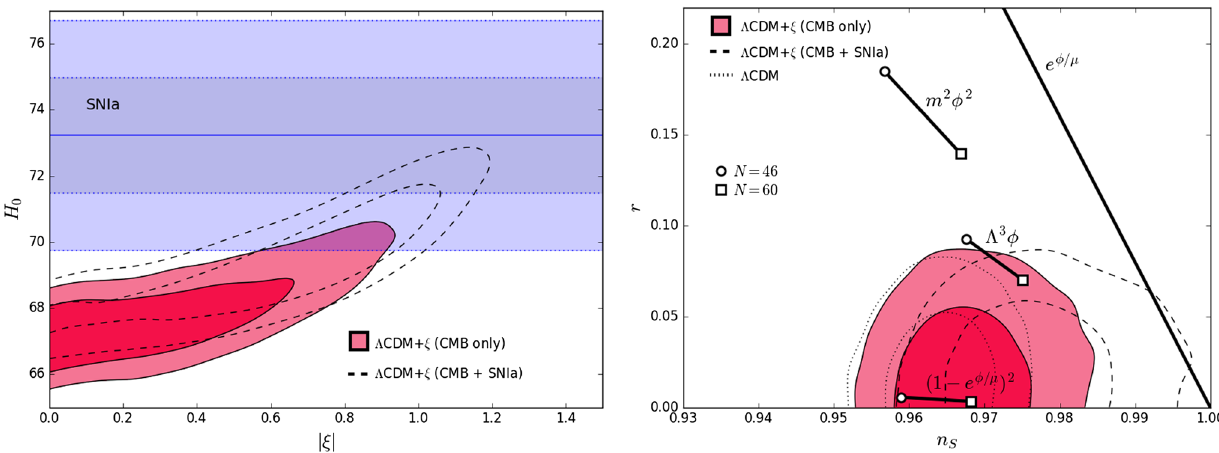
Fig. 4 CMB constraints on lepton number asymmetries for the nine- parameter model including tensor perturbations. Contours are 68 and 95% uncertainties from CMB-only ( red-shaded regions ), and CMB + supernovae( dashedlines ). Left constraintasafunctionof ξ and H 0 .The filled region is the Riess et al. constraint on H 0 from supernovae. Right